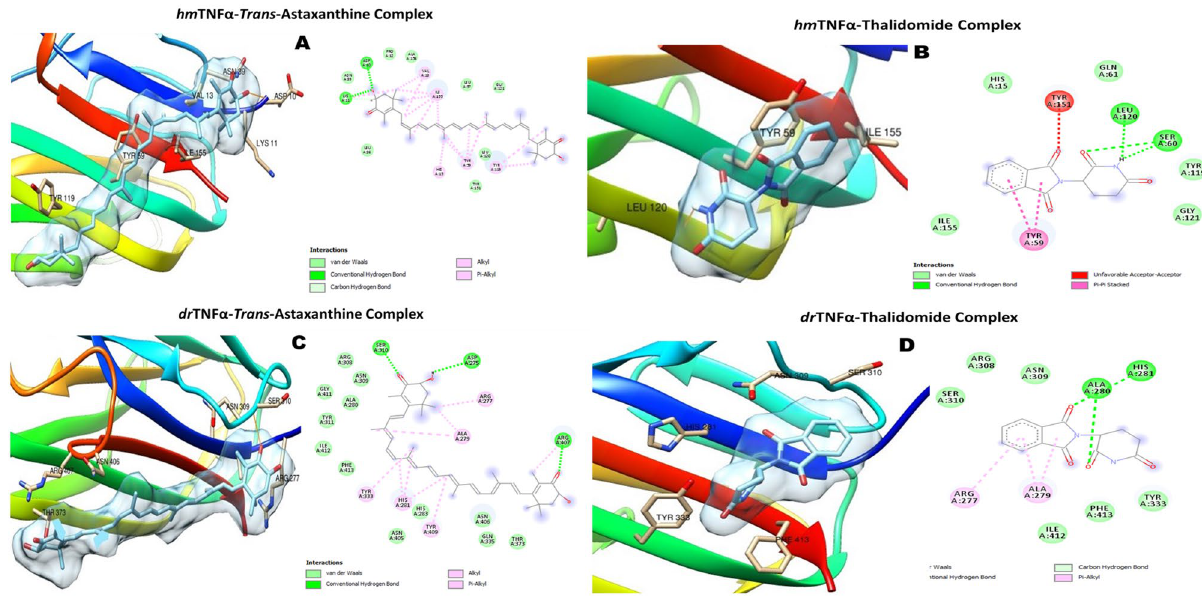
Figure 6. The 3D and 2D molecular complexations of Human TNFα (hmTNFα) with TA ( A ) and Thalidomide ( B ), and Drosophila TNFα (drTNFα) with TA ( C ) and Thalidomide ( D )